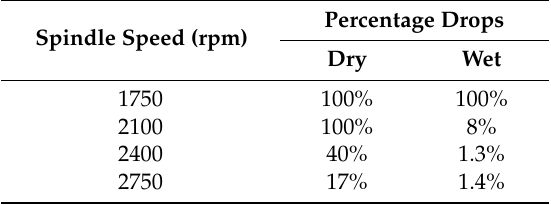
Table 2. Spindle speed percentage